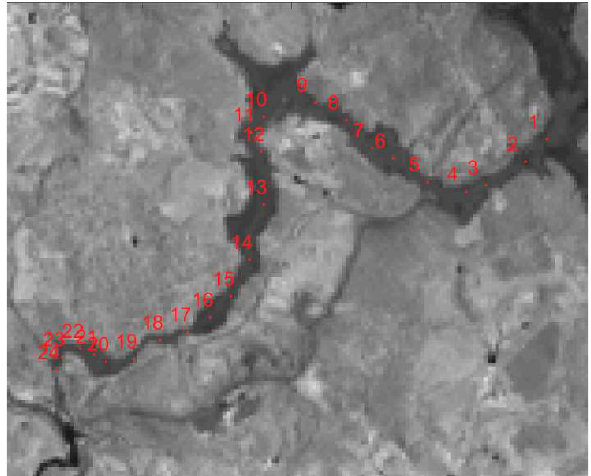
Figure 2 – Location of the points along the Côrrego do Feijão (blue) superposed to the Landsat 8/OLI near infrared band.